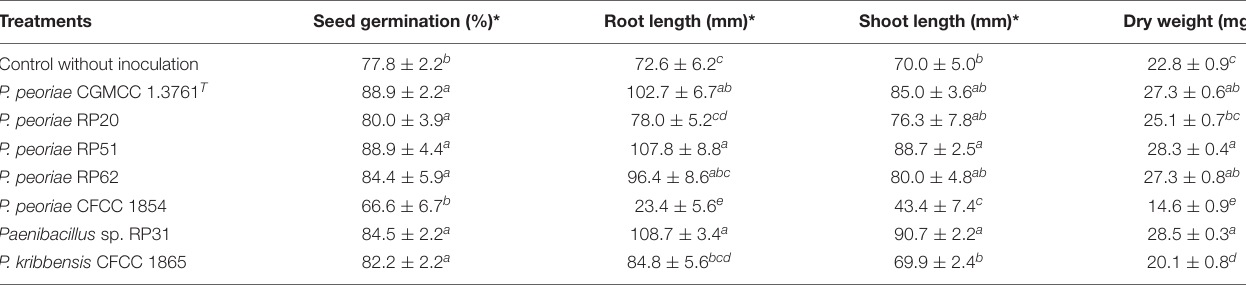
*Data are presented as mean value ± standard error. The different letters following the values in the same column indicate significant difference between the treatments at p < 0.05.